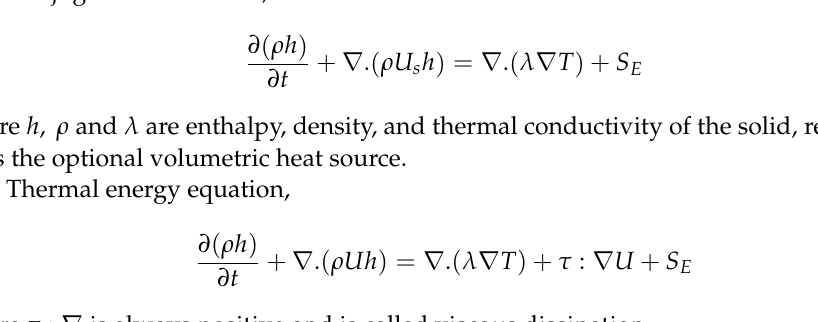
Figure 5. Outlet temperature for various number of elements ranging from 400,000 to 1,300,000.